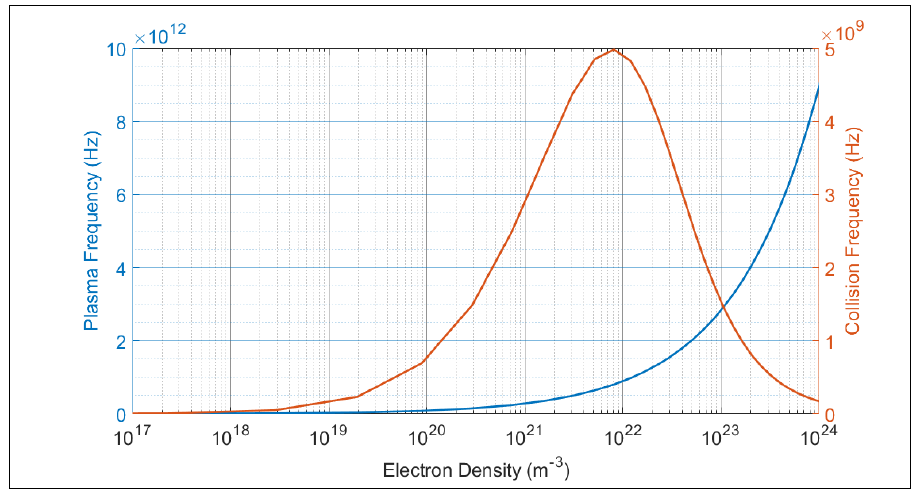
Figure 2. Plasma and collision frequencies as functions of the density of a plasma in thermal